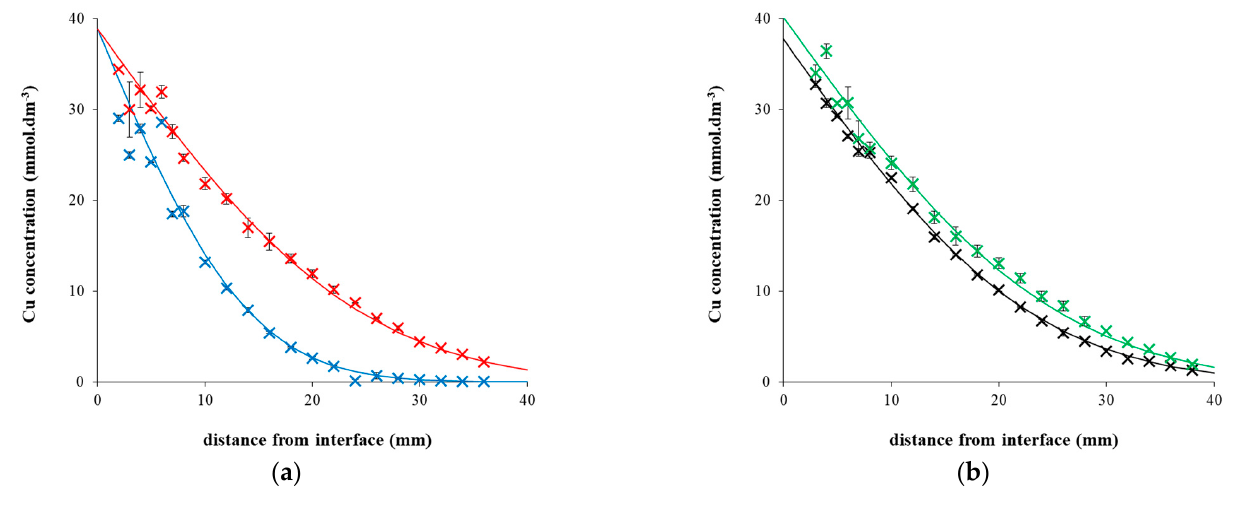
Figure 1. ( a ) Concentration profiles of copper(II) ions in agarose hydrogel enriched by chitosan (0.5 mg g − 1 ) after 24 h (blue) and 72 h (red). ( b ) Concentration profiles of copper(II) ions in pure agarose hydrogel (black) and hydrogel enriched by chitosan (1 mg g − 1 ; green) after 72 h. Experimental data are fitted by Equation (1). Table 1. Initial and boundary conditions of diffusion experiments. Concentration profiles in Figure 1 are fitted by Equation (1). The diffusion coeffi- cient used for the fitting was determined on the basis of Equation (2) from the slope of dependency shown in Figure 2.